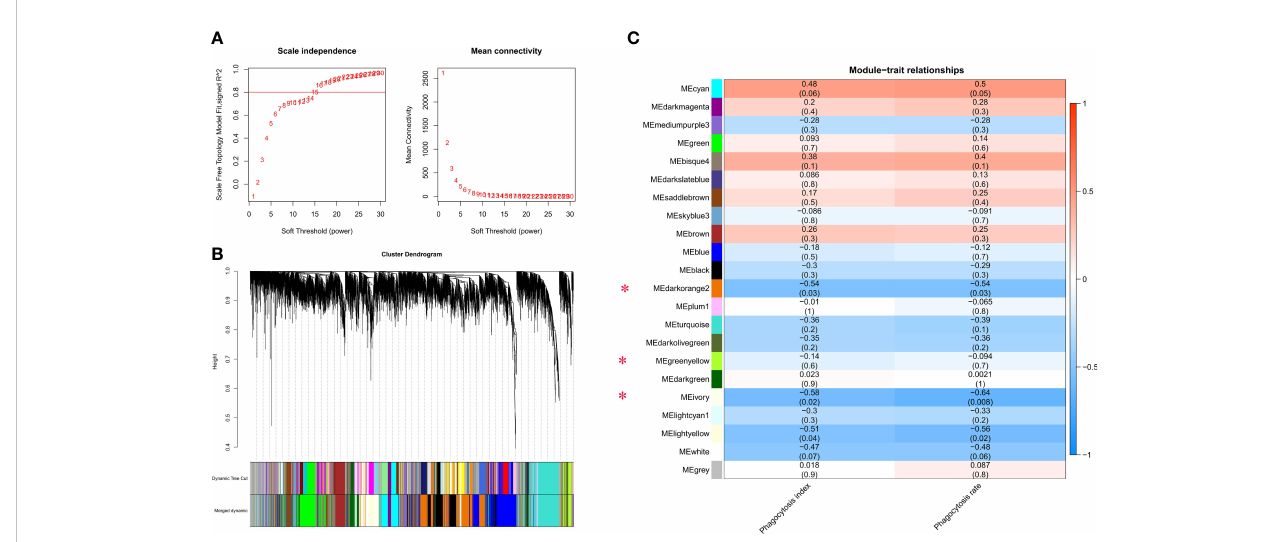
FIGURE 4 Gene coexpression module analysis of the macrophage phagocytosis index and phagocytosis rate. (A) Scale-free topology model and mean connectivity. (B) Cluster dendrogram revealed the module colors and the merged dynamics. (C) Module relationships with the phagocytosis index and phagocytosis rate. Modules signi fi cantly correlated with the phagocytosis index and phagocytosis rate are marked with a red asterisk. There are two values in each cell: the upper represents the absolute value of the correlation coef fi cient, and the lower represents the P value. Red and blue colors represent positive and negative correlations,